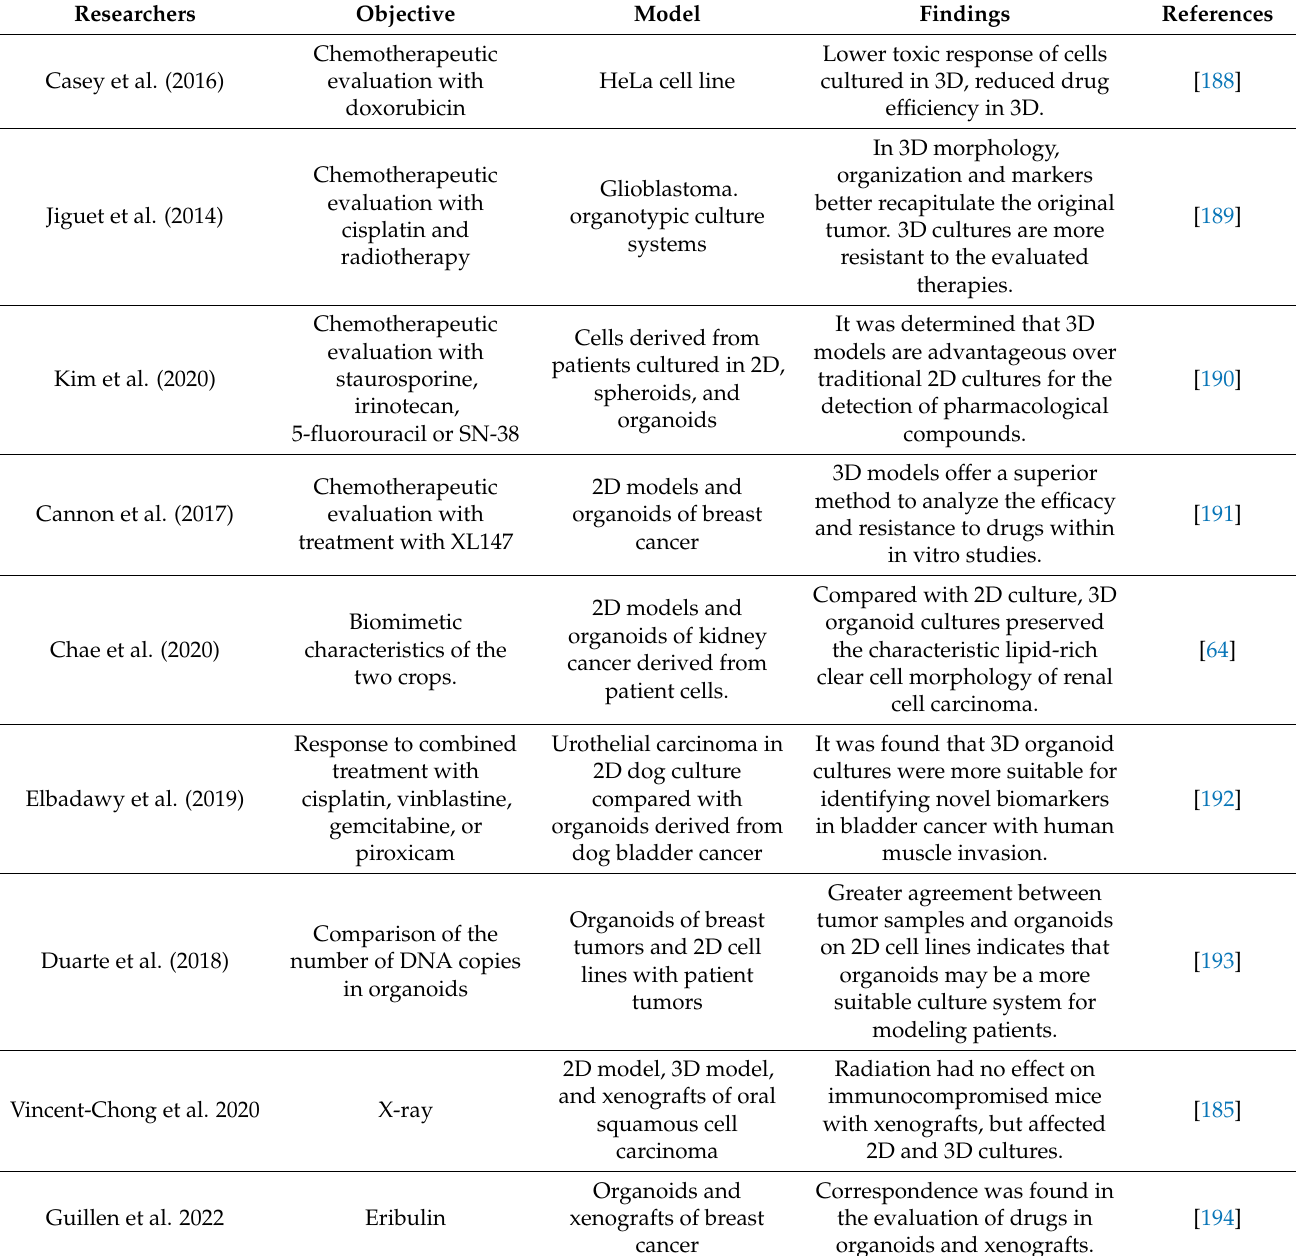
Table 2. Comparison between 2D cultures and organoids for the evaluation of anticancer